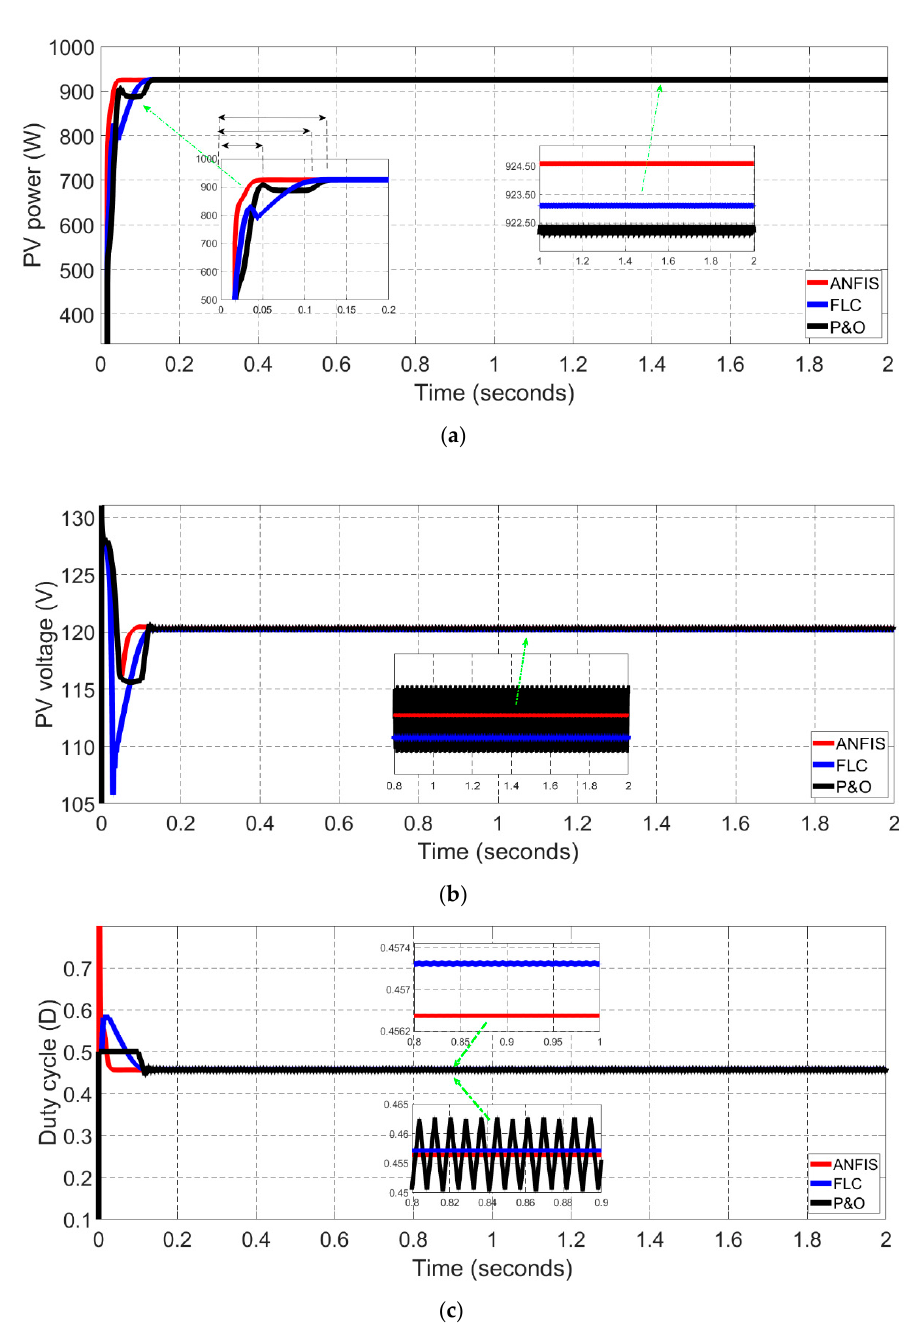
Figure 10. PV array system for the ANFIS method versus the P&O and FLC methods under a fixed irradiation condition: ( a ) Power, ( b ) voltage, and ( c ) duty cycle. Table 4. A comparison of the properties of the ANFIC, perturb and observe (P&O) and fuzzy logic controller